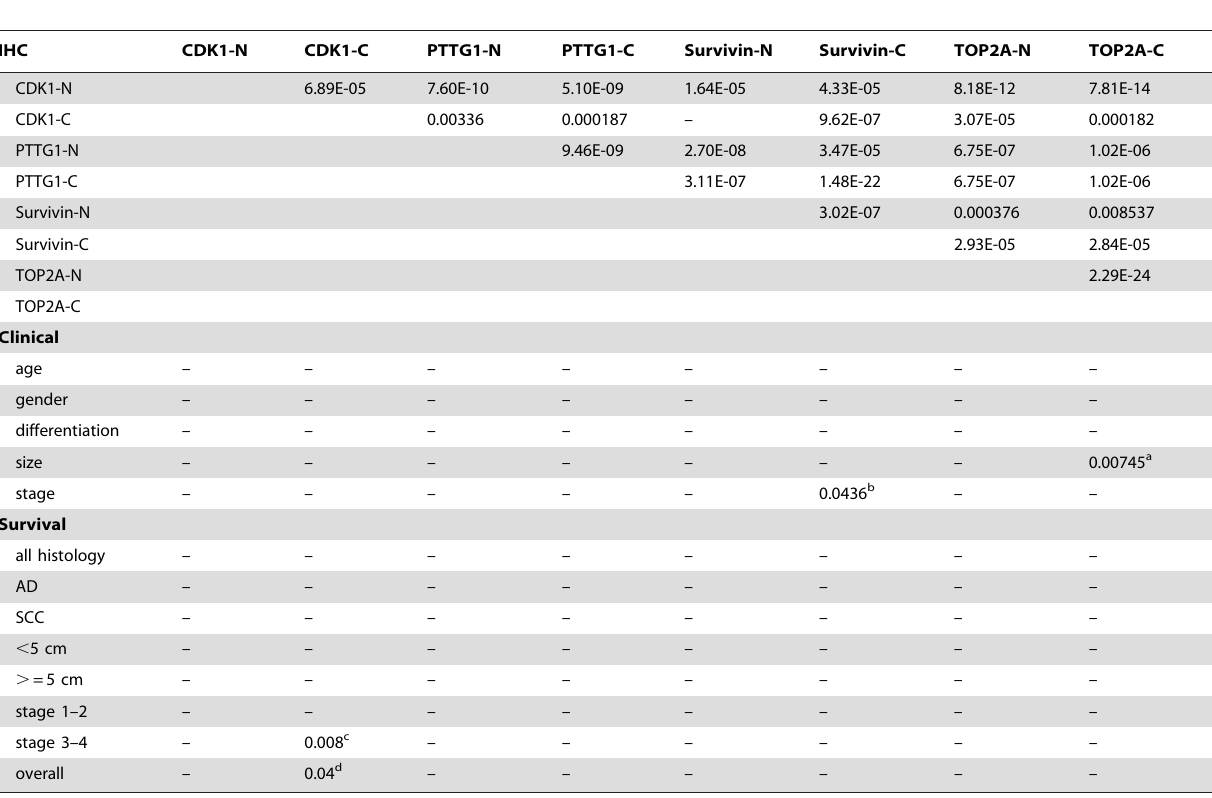
Table 2. Associations of IHC staining, clinical factors and patient survival.